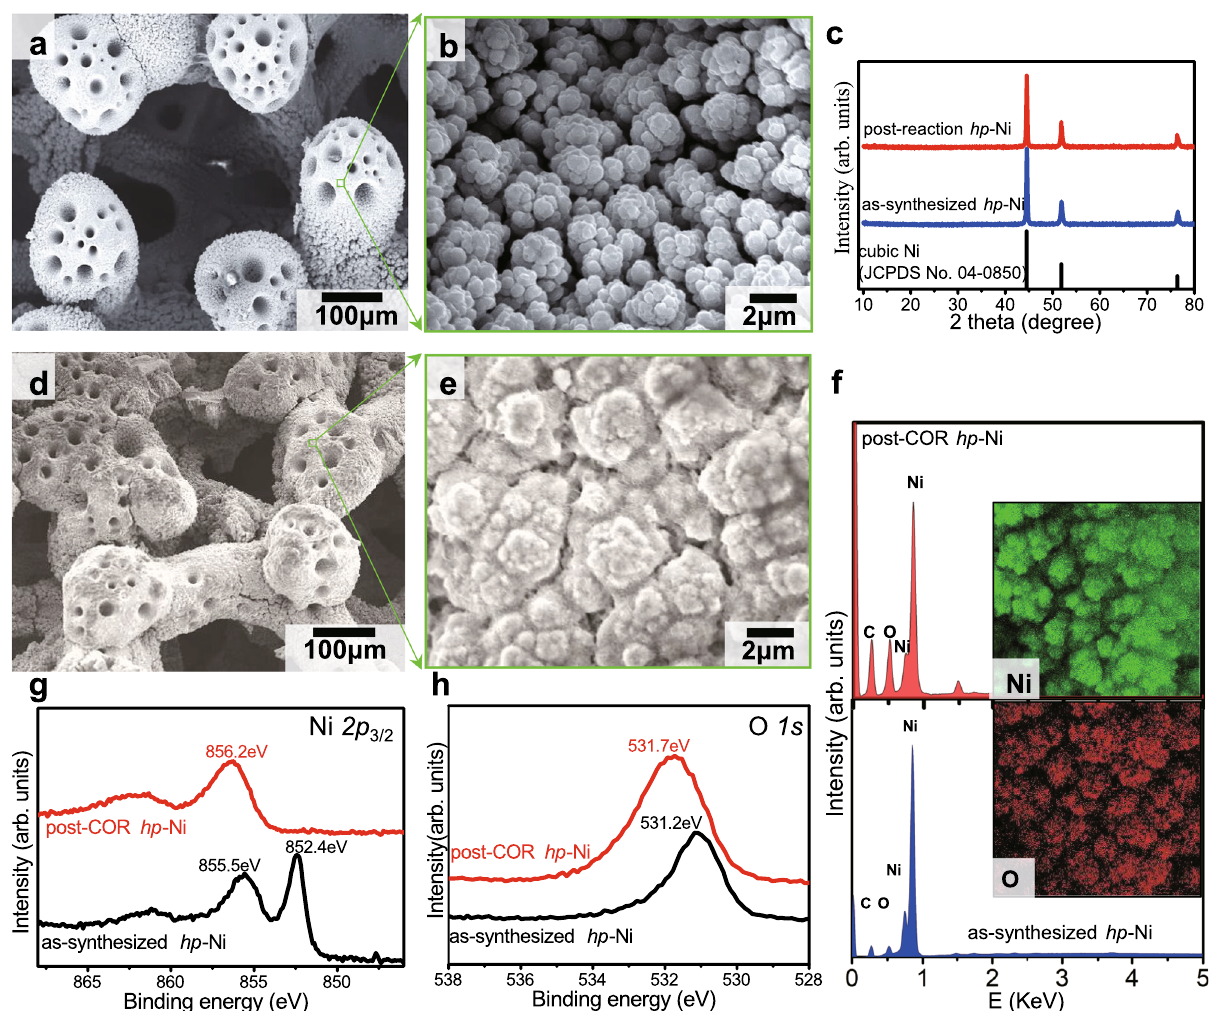
Fig. 2 Material characterization of electrode. a SEM images of an as-synthesized hp -Ni sample. b Zoom-in view of the green square in ( a ). c X-ray diffraction patterns of as-synthesized (blue spectrum) and post-COR samples (red spectrum) along with the standard reference of cubic Ni (black spectrum). d SEM images of a post-COR hp -Ni sample. e Zoom-in view of the green square in ( d ). f EDS spectrum of as-synthesized (blue spectrum) and post-COR sample (red spectrum). Inset: Ni, and O element mapping of the post-COR sample. XPS spectrum of ( g ), Ni 2p states, and h O 1s state of the samples before (black spectra) and after (red spectra)